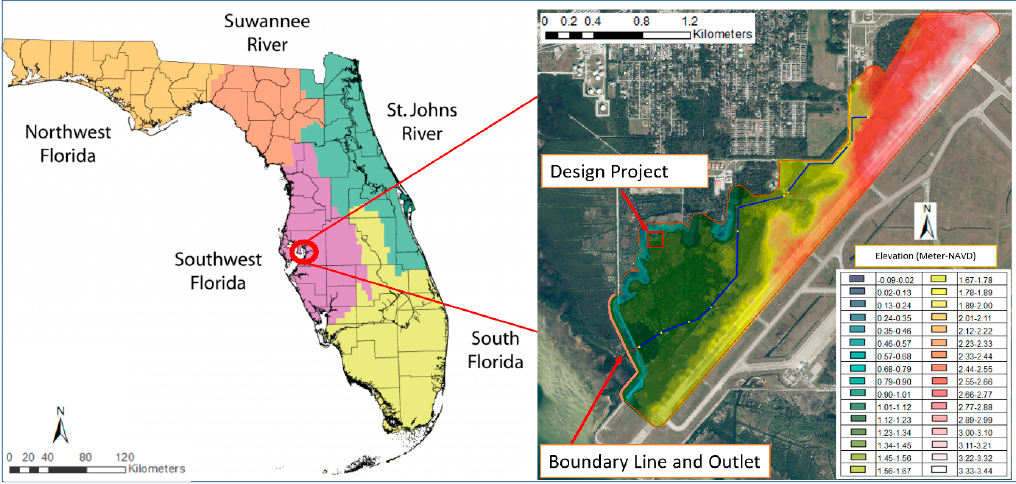
Figure 1. Location of project area in Southwest Florida.